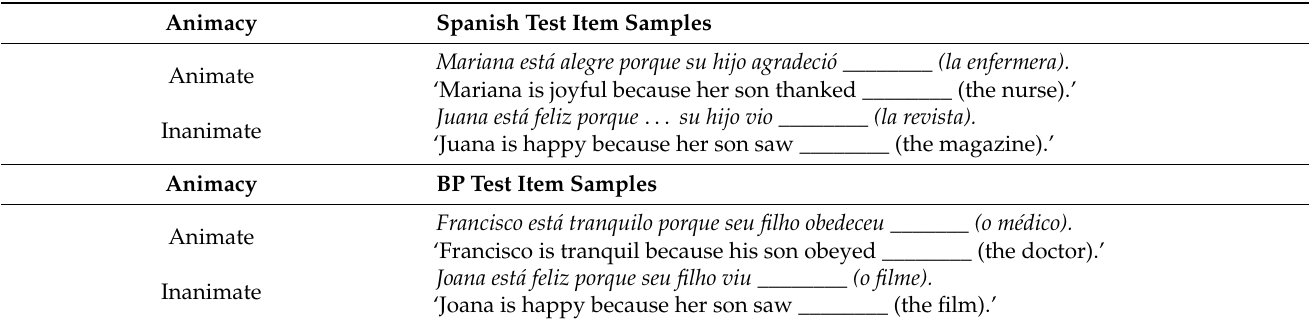
Table 3. Spanish and BP EPT item samples per condition.